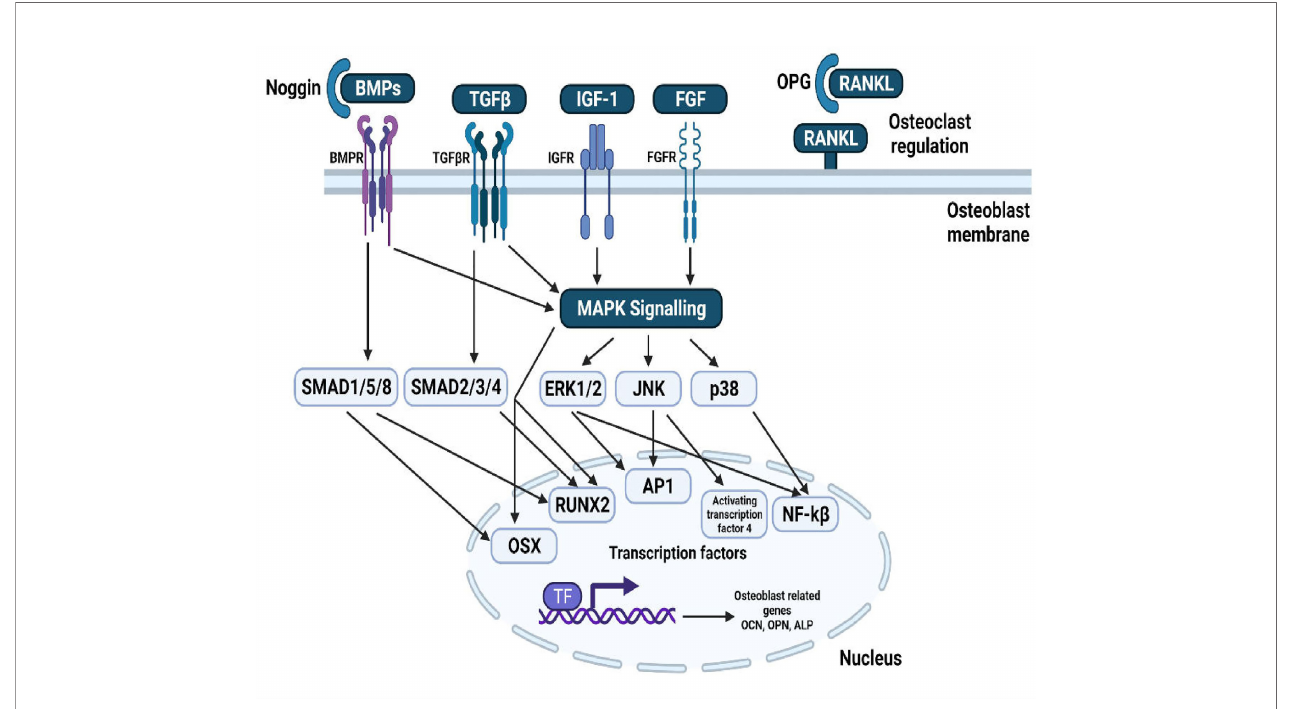
FIGURE 7 | Effect of hesperidin on signalling pathway regulating differentiation of